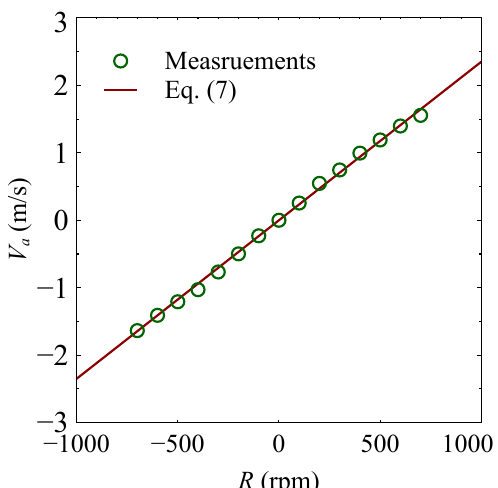
Figure 2. Flow velocity against rotational speed with the O-tube mode under steady state